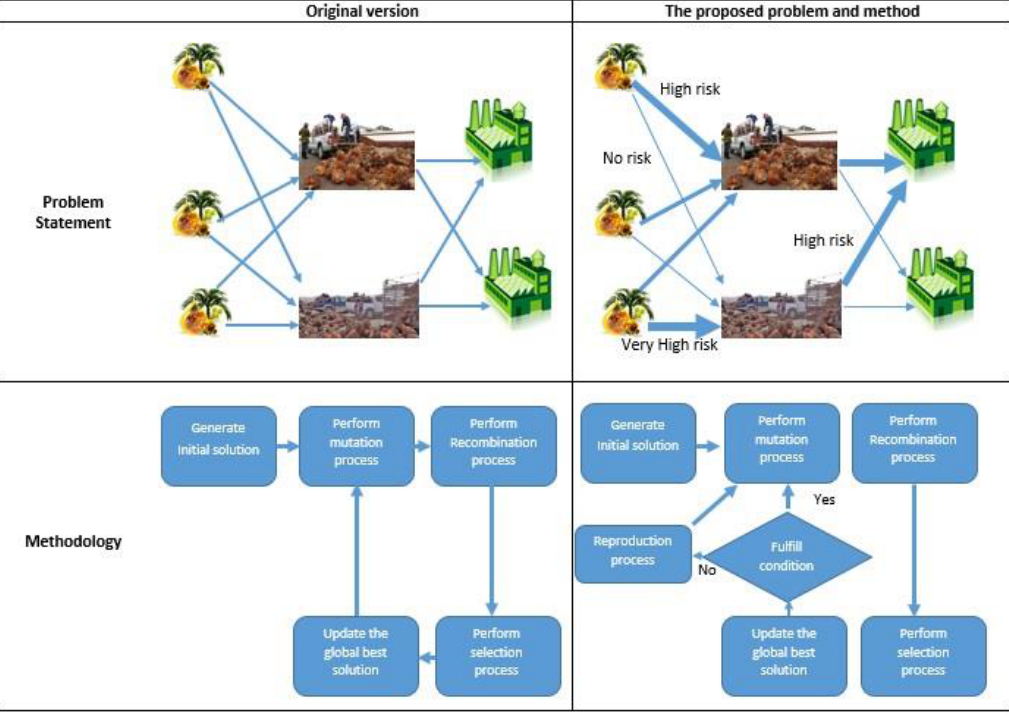
Table 11. Comparing results of DE and MDE algorithms with the optimal solution generated by Lingo v.11.